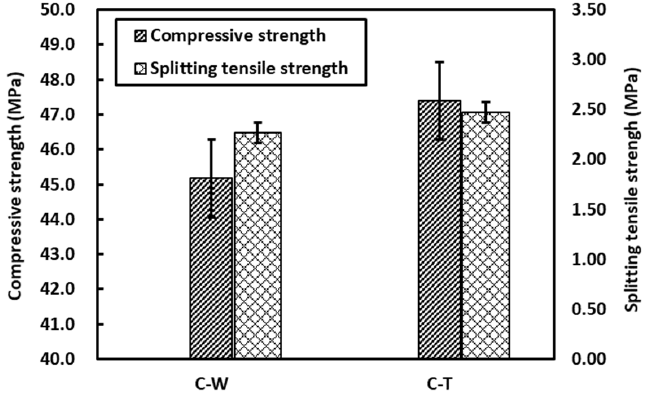
Figure 10. The mechanical performance of concrete (C-W group vs. C-T group).